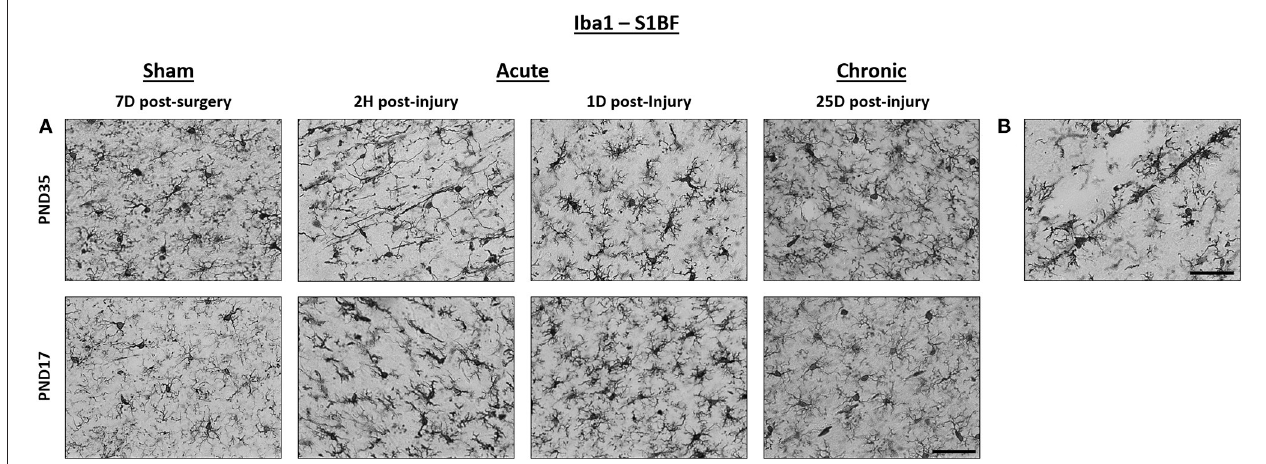
FIGURE 2 | TBI activated microglia in both PND17 and PND35 rats. Iba1 stained microglia in PND17 and PND35 rats. (A) At 2h (H), 1 day (D), and 25D post-injury, microglial activation was observed in PND17 and PND35 rats subjected to TBI compared to uninjured shams. All representative images are from the S1BF. (B) Rod microglia were observed in PND17 rats but not PND35 rats. Scale bars = 50 µ m. (sham n = 39, TBI n =